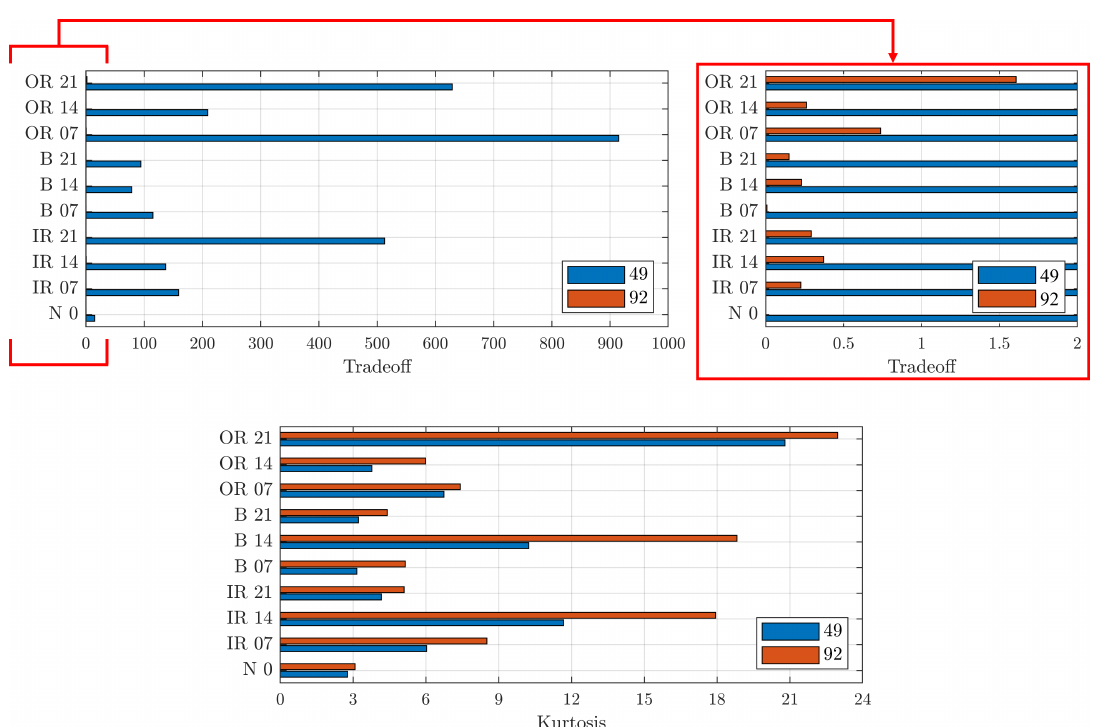
Figure 13. Comparison of TO ( top ) and kurtosis ( bottom ) between Indices 49 and 92 for different defect locations and diameters. On the top-right, zoom of TO graph to highlight values for Index 92. On the y -scale, the letters indicate the position of the defect and the numbers indicate the defect diameter size in thousandths of an